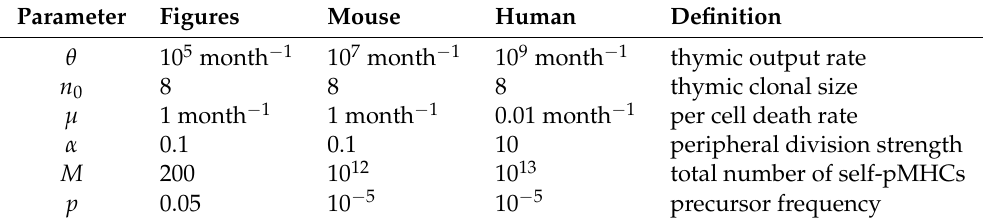
Table 3. Parameters of the epitope distance model. The values used in Figures 14 and 15 are compared with conjectured values in mice and humans. The thymus produces new clonotypes at rate θ , each starting with n 0 cells. The parameter α is the rate of cell division in the periphery, M γ , divided by θ n 0